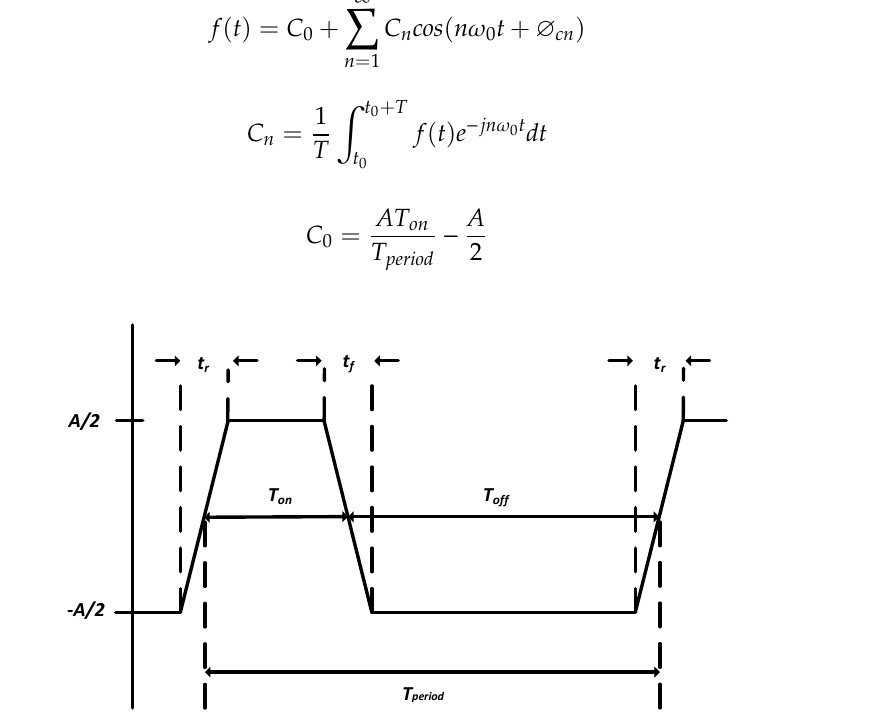
Figure 1. A typical trapezoidal waveform with a limited rise/fall time.